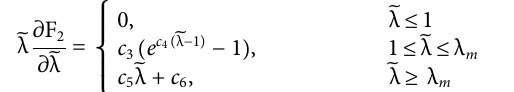
Table 1 . Fiber stress response is de fi ned as: